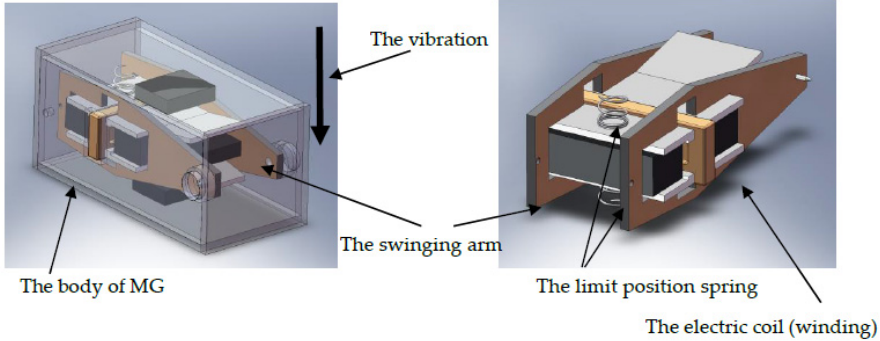
Figure 7. The basic magnetic circuit of MG, structural design with magnetic damping in the limit position of the rocking arm.